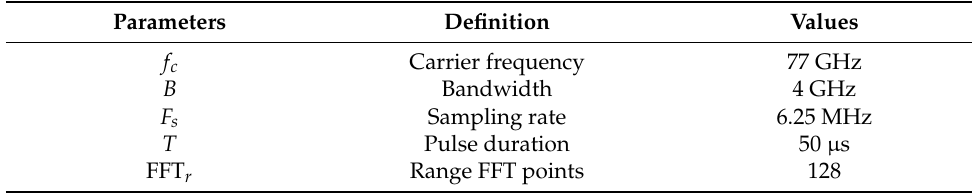
Table 2. Parameters for the LFMCW Radar System.